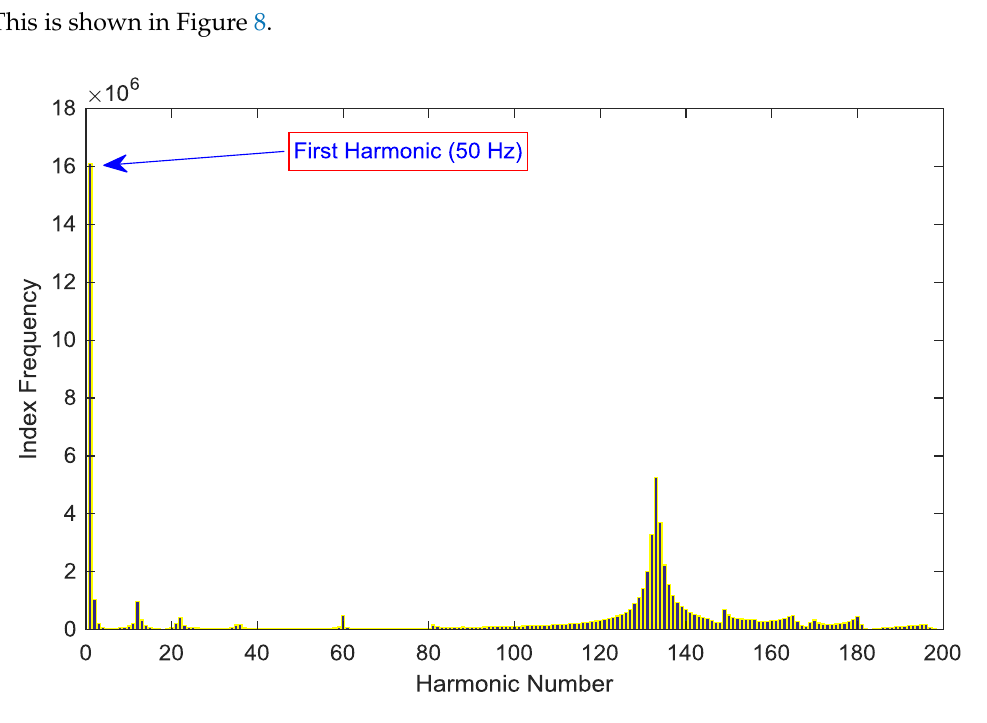
Figure 8. Diagram of 𝑣 𝑎𝑓 .